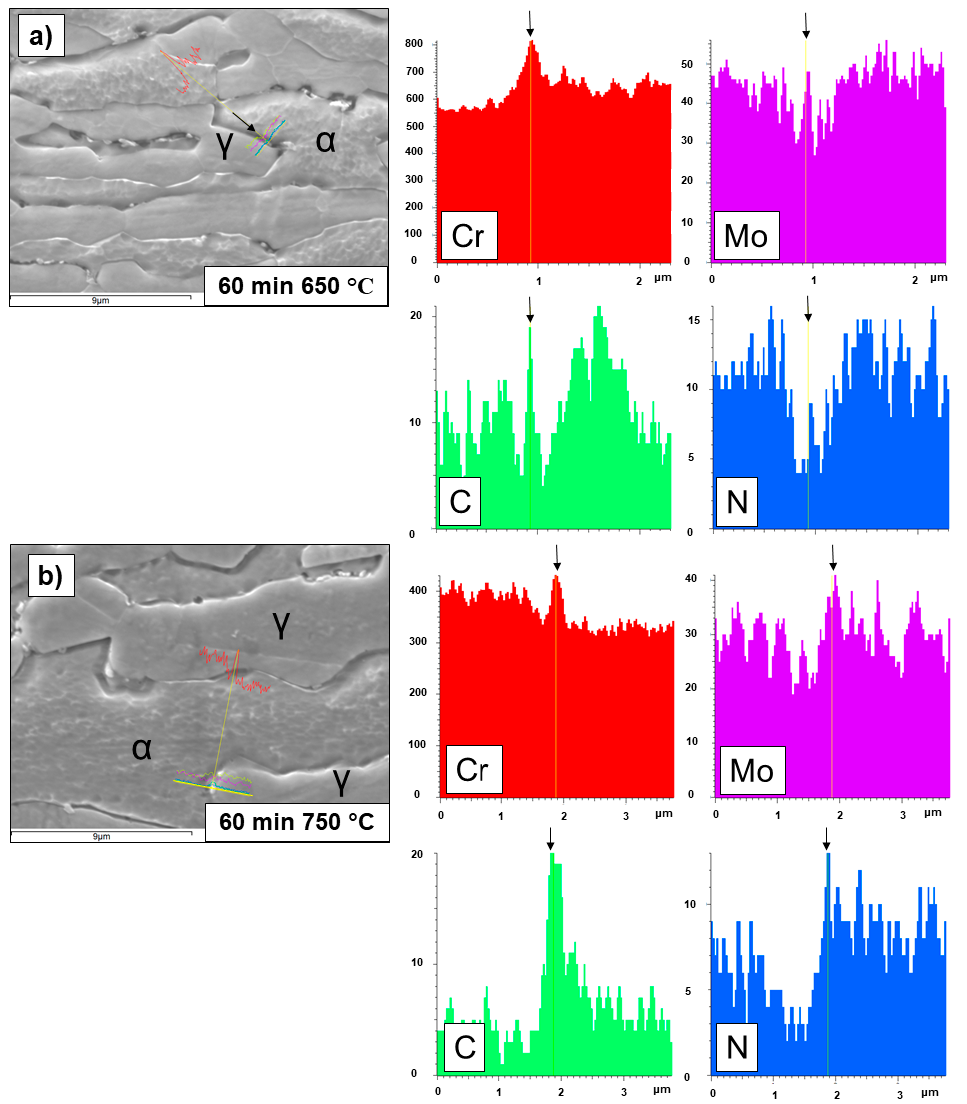
Figure 9. SEM-BSD micrographs of DSS 2304 aged for 60 min at 650 ( a ) and 750 °C ( b ), after DL-EPR test. Scanning electron microscope–energy dispersion spectroscopy (SEM-EDS) line profile analysis of: chromium (red), molybdenum (green), carbon (blue) and nitrogen (purple).